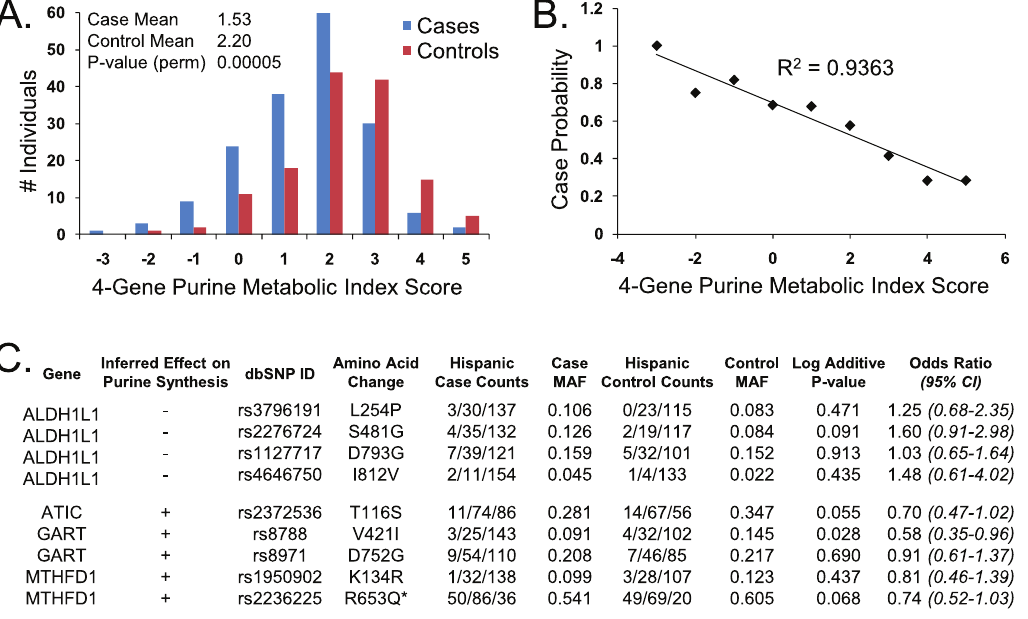
Figure 5. Nonsynonymous Variants in the Hispanic Signature. A. Hispanic case/control distributions of purine Metabolic Index Scores calculated from common synonymous variants (n=9) in 4 genes ( ALDH1L1, ATIC, GART, MTHFD1 ). The P-value shown is not adjusted for multiple comparisons (see text). B. The data in panel A transformed to demonstrate the fraction of cases as a function of purine Metabolic Index Score. C. Attributes of the 9 SNPs that went into the purine MIS calculations of panel A. ‘‘Inferred Effect on Purine Synthesis’’ is the inferred effect of that particular gene product on purine biosynthesis (see text for details). Case and control counts are given as individual genotype distributions: # minor allele homozygotes/ # heterozygotes/ # major allele homozygotes). Log additive P-values and odds ratios were calculated as in Methods using only Hispanic samples and not multiple-testing adjusted. *Minor Q653 MTHFD1 enzyme variant is the major allele in Mexican-American populations (http://hapmap.ncbi.nlm.nih.gov/). doi:10.1371/journal.pone.0028408.g005 (which harbor 149 rare, non-coding variants) designated as relevant to homocysteine metabolism (see Table S3) is shown in Figure 6. The signal was suggestive of an association (P- value =0.004; P-value = 0.076 when adjusted for multiple com- parisons) and was the most noteworthy trend seen in the non- Hispanic white sub-population. The odds ratio comparing individuals with MIS below 0 to those above was 3.4 (95% CI 1.2 – 9.8).